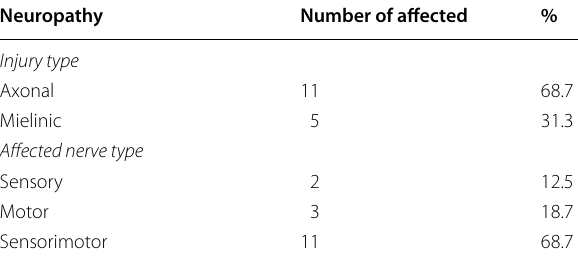
Table 3 Main outcomes associated to peripheral neuropathy